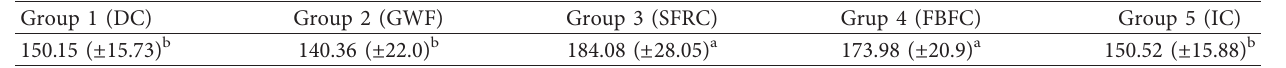
Table 3: Flexural strength values and standard deviations.